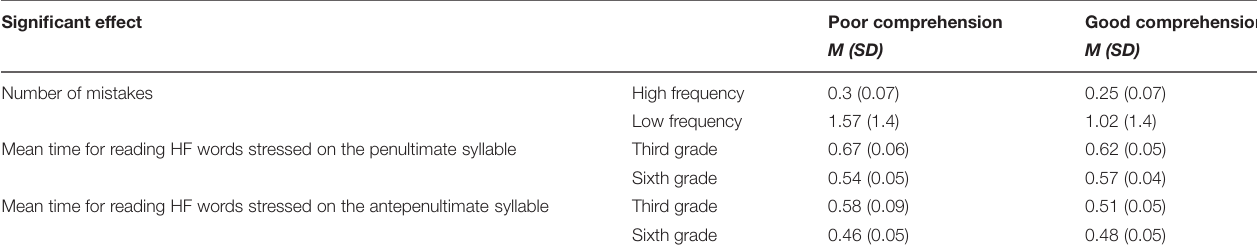
TABLE 5 | Mean and SD of the primary significant effects in the word